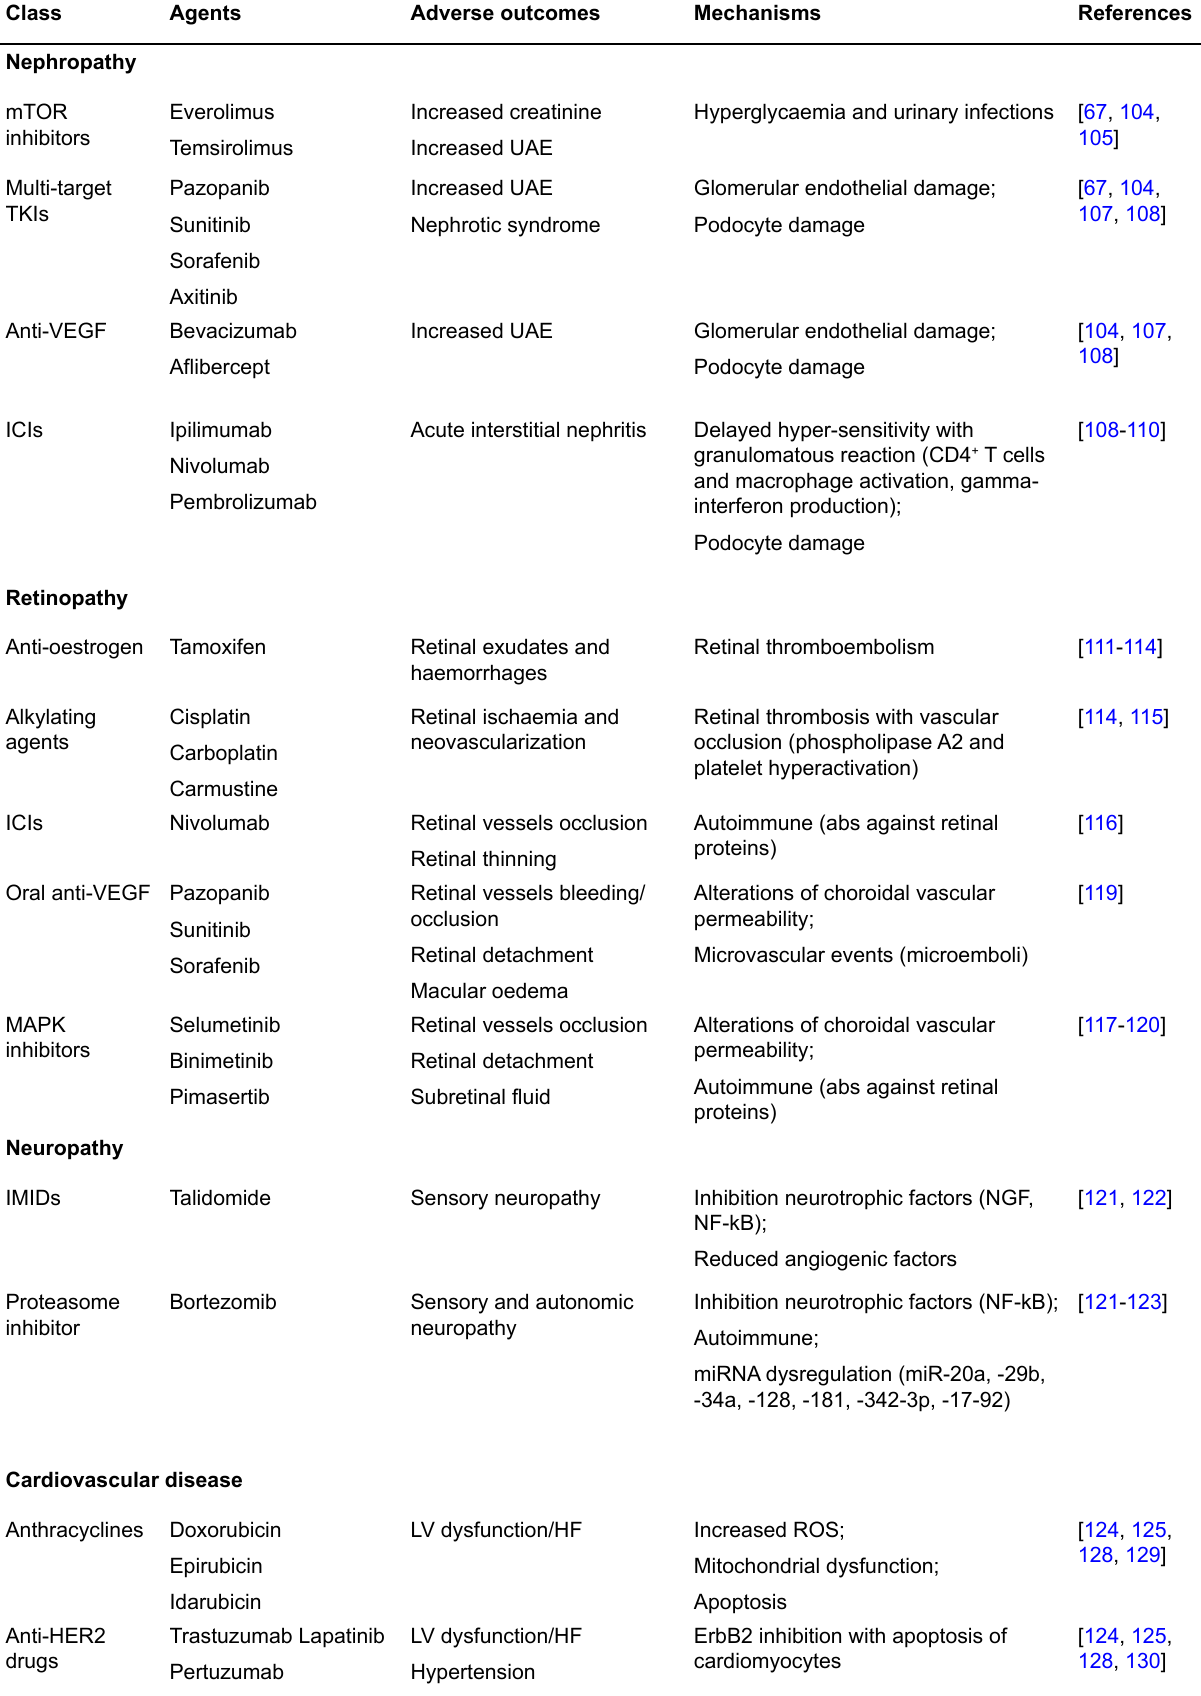
Table 2. Anticancer drugs effects on renal, retinal, neuronal and cardiovascular events Class Agents Adverse